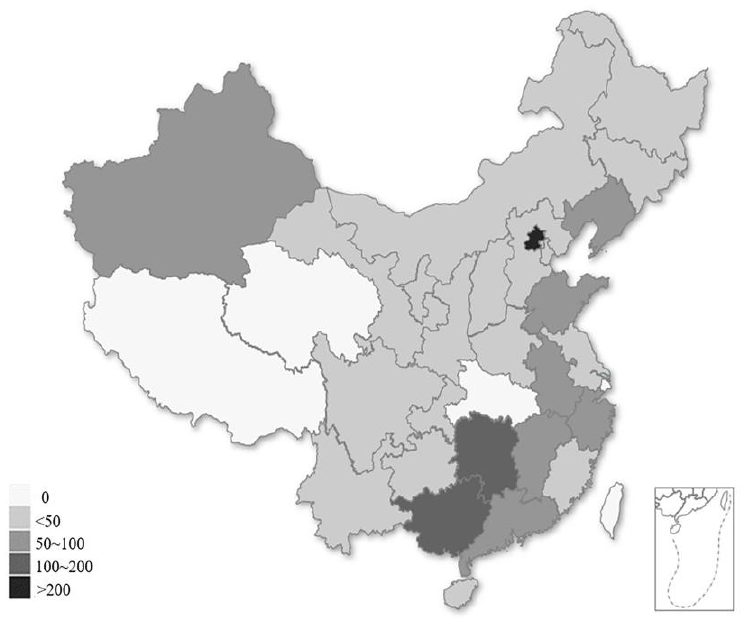
Figure 2. Provincial distribution of the SLE patients in our study, according to the hospitals at which they were registered. Table 1. SLE patient demographics and clinical profiles.